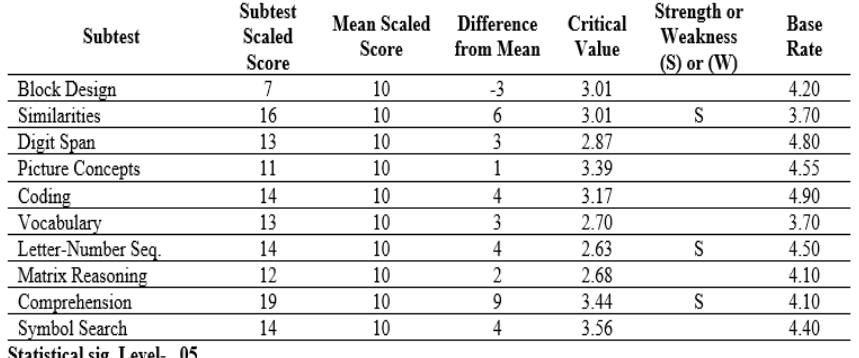
Table A-4. Determining strengths and